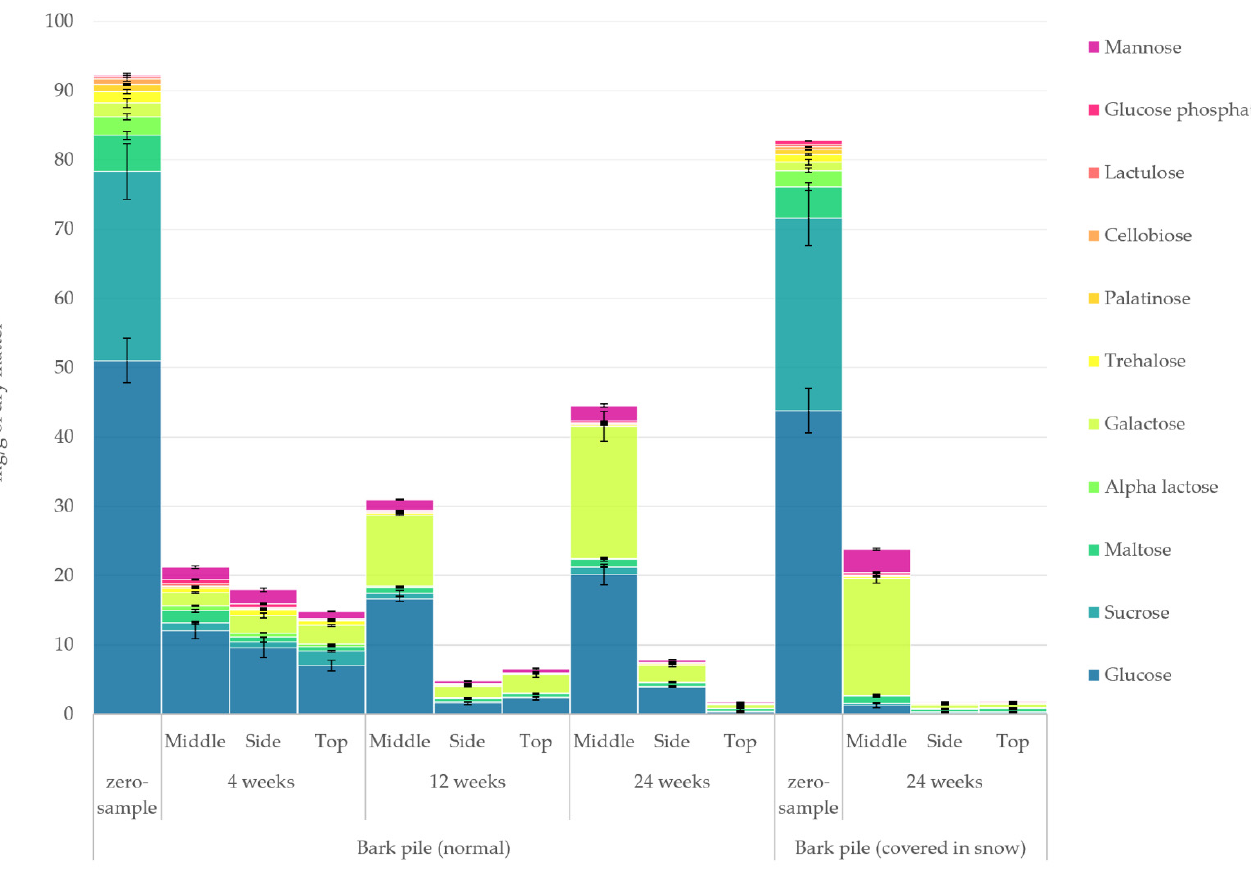
Figure 9. Quantified amounts of mono- and disaccharides in the hydrophilic extracts of stored